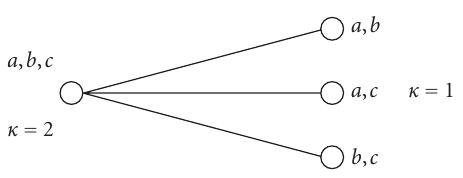
Figure 3.2. The Cropper Claw; every block a clique, but HC is not su ffi cient for a proper ( L , κ )-